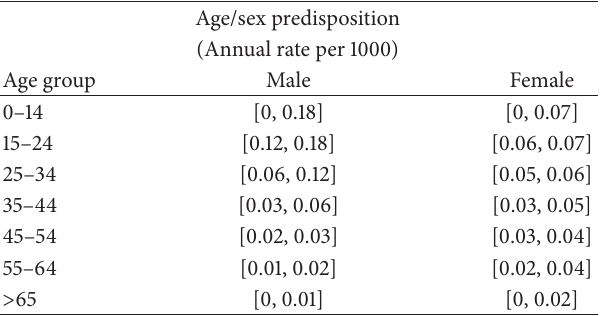
Table 1: Age/sex predisposition, adapted from